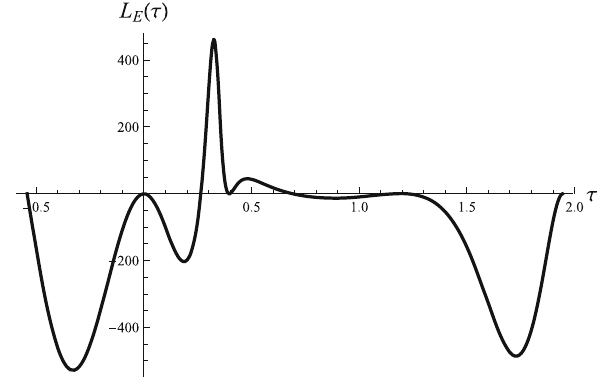
Fig. 8 L E (τ) for the Euclidean wormhole